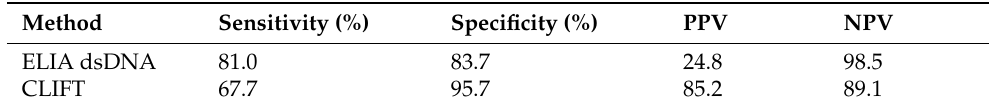
Table 3. Sensitivity, specificity, positive and negative predictive value of ELIA dsDNA and CLIFT methods. PPV—Positive predictive value; NPV—Negative predictive